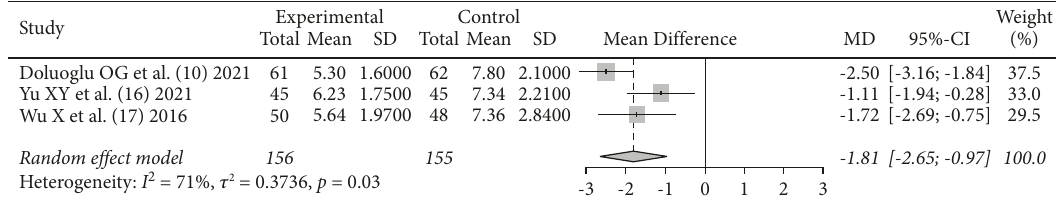
Figure 4: Comparison of hospital stay after TURBT between SA +ONB and SA